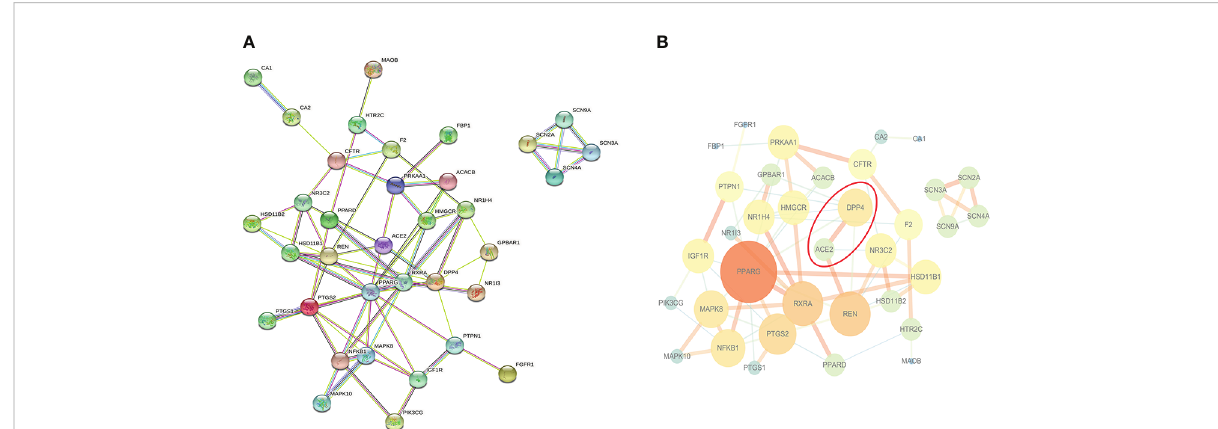
FIGURE 2 PPI network of potential targets. (A) Original graph from STRING online platform: Nodes are proteins, and edges of different colors are the interaction between proteins; (B) Relationship network graph processed by Cytoscape software: The larger the node and the darker the color, the more important the node is; the thicker the edge and the darker the color, the closer the relationship between